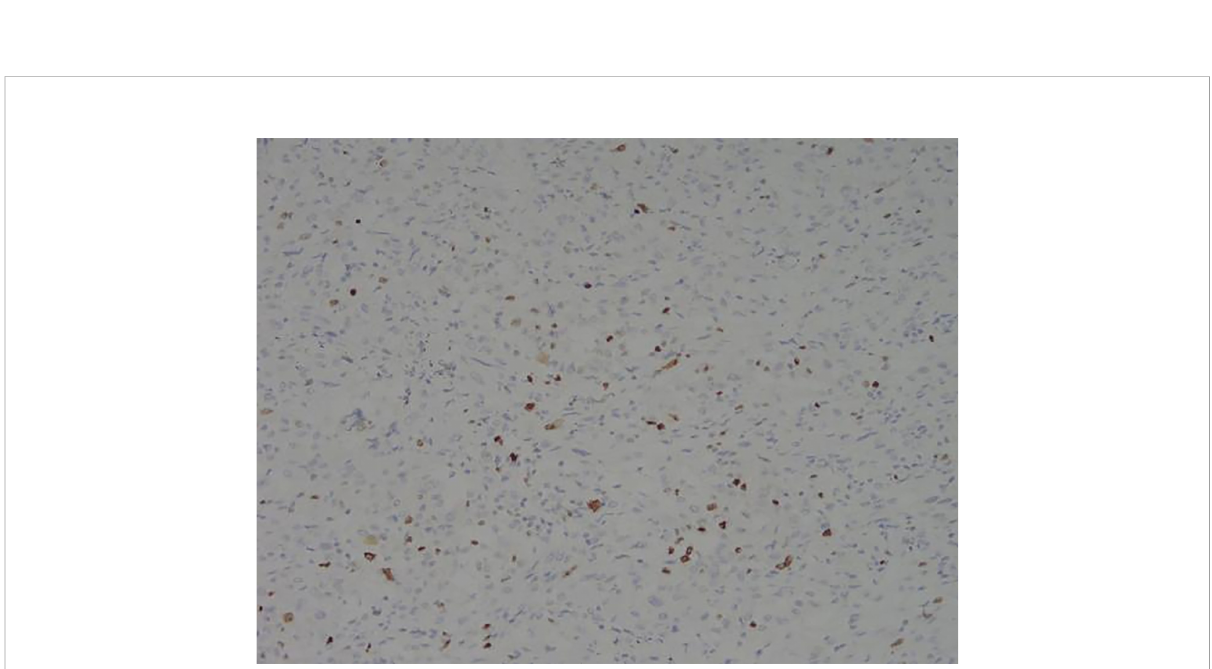
FIGURE 8 Representative image of Ki67 expression (magni fi cation,